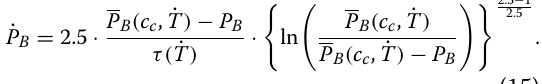
Figure 5 summarizes the model parameters in Eqs. (15) and (17), determined by dilatometric